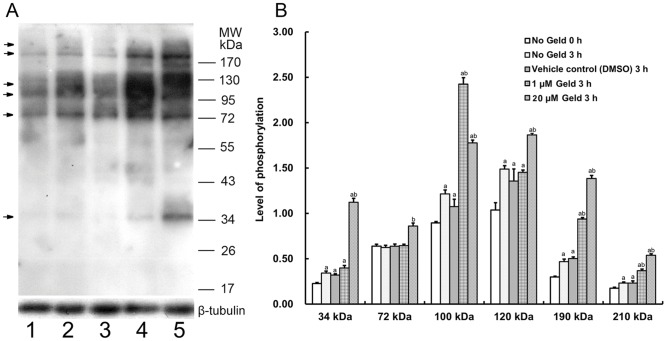
Effect of Geld on protein tyrosine phosphorylation in human sperm during capacitation.A) Sperm lysates were resolved by sodium dodecyl sulfate polyacrylamide gel electrophoresis (SDS-PAGE), transferred to Immunoblot-P membranes, and probed with anti-phosphotyrosine (PY20) antibody. Lanes 1, 2, 3, 4, and 5 contained lysates from sperm that were incubated in absence of geldanamycin (Geld) as blank control for 0 h and 3 h, with dimethyl sulfoxide (DMSO, 0.1%, v/v) as the vehicle control, 1 µM Geld, or 20 µM Geld for 3 h under capacitation conditions. B) The phosphorylation levels were quantified by the intensity ratio of bands to that of the loading control, β tubulin. The results are expressed as means ±SEM (n = 5). a, compared to the blank control at 0 h, P<0.05; b, compared to the vehicle control at 3 h, P<0.05.